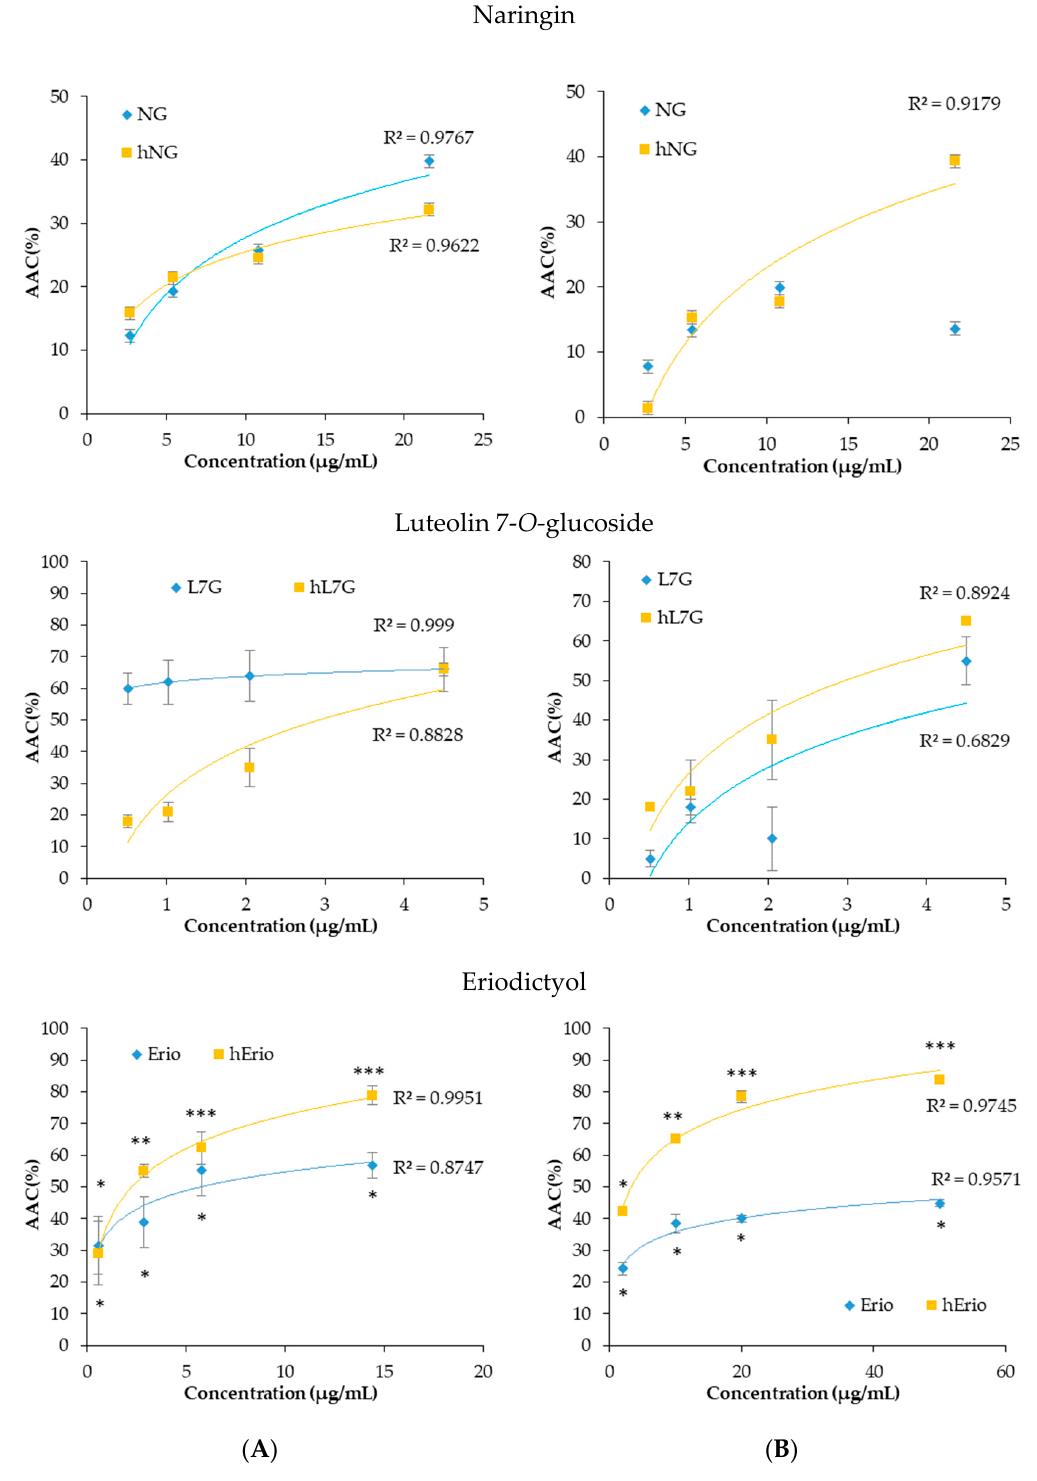
Figure 7. Dose-response curves of inhibition of peroxyl radical-induced DCFH oxidation in macrophages (6 × 10 4 cell per well) ( A ) and spleen cells (5 × 10 5 cells per well) ( B ) using a cellular antioxidant activity assay in the presence of heated and native molecules.